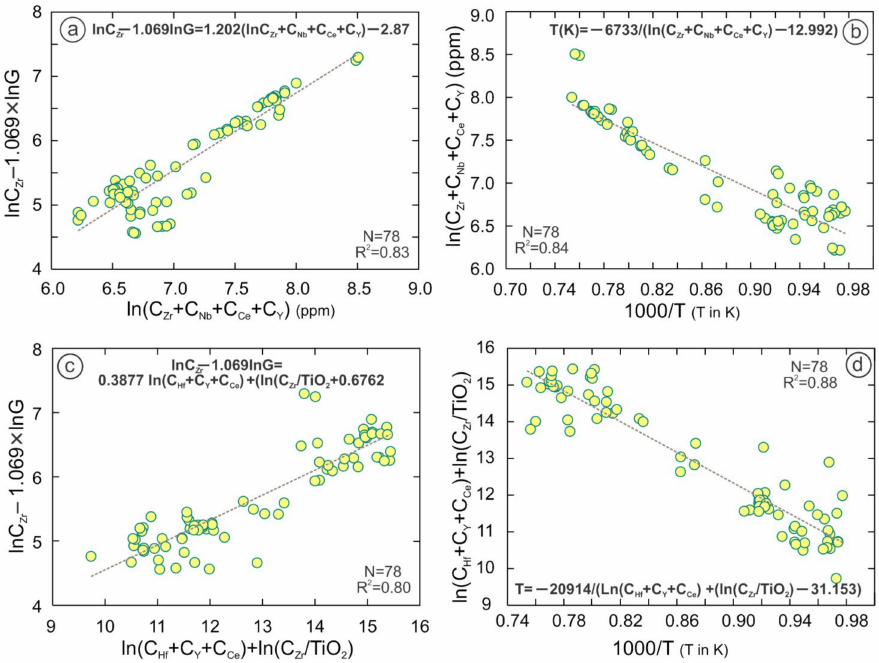
Figure 12. ( a , b ) ln (C Zr + C Nb + C Ce + C Y ) correlate to lnC Zr − 1.069lnG and 1000/T. ( c , d ) The suggesting HFSEs parameter ln(C Zr + C Nb + C Ce + C Y ) + ln(CZr/TiO 2 ) versus the lnC Zr − 1.069lnG and 1000/T indicate that this parameter could be dependent on the temperature.